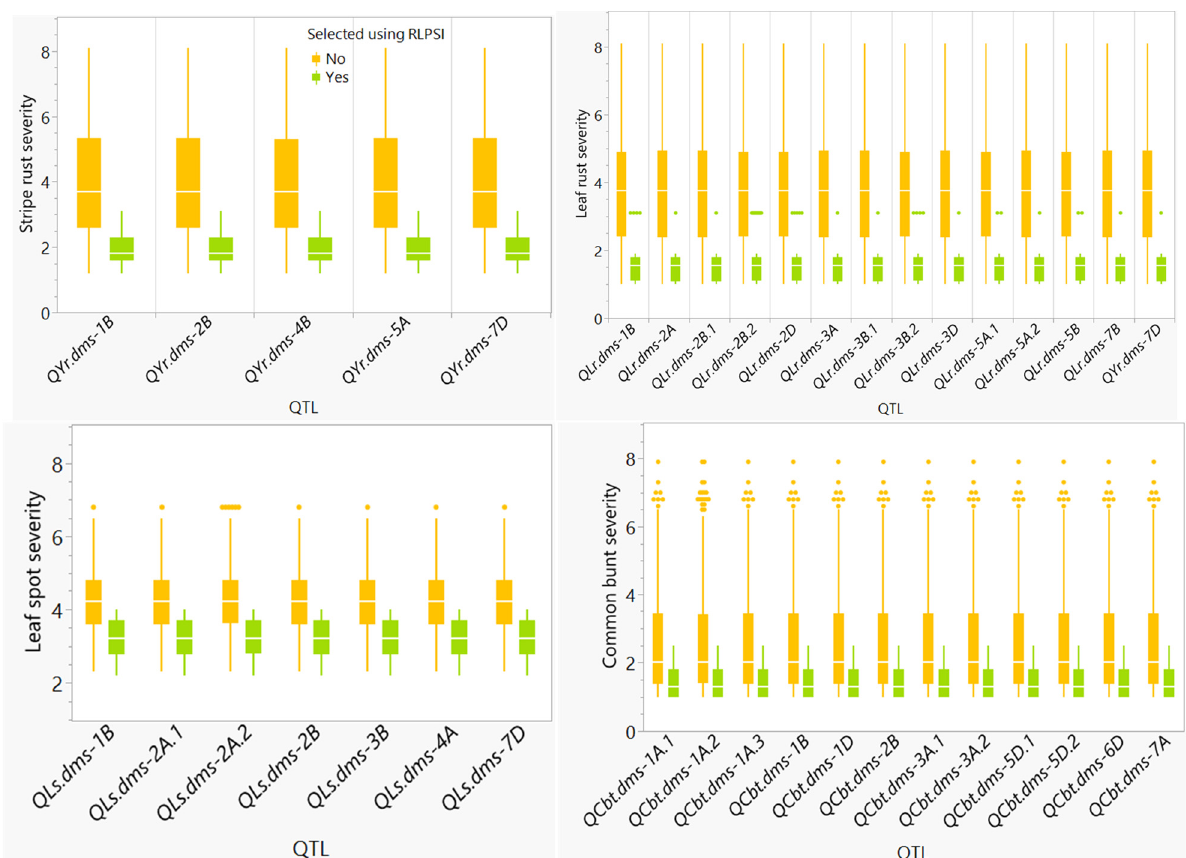
Figure 6. Comparisons of the overall disease severity recorded in all combined environments between selected and unselected genotypes at each genomic region identified using genome-wide association analysis. Disease resistant donor genotypes were selected based on a restricted linear phenotypic selection index. The dots indicate outlier scores.